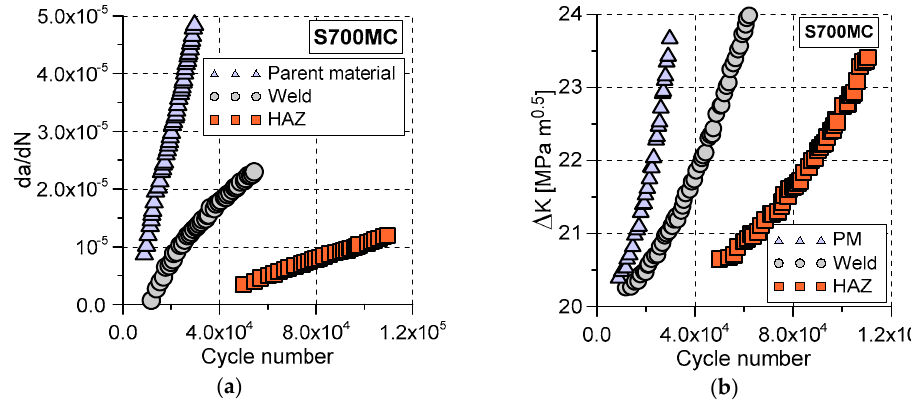
Figure 11. Variations of the crack propagation parameters: as a function of the cycle number for the parent material, weld and HAZ: ( a ) da/dN; ( b ) ∆ K.